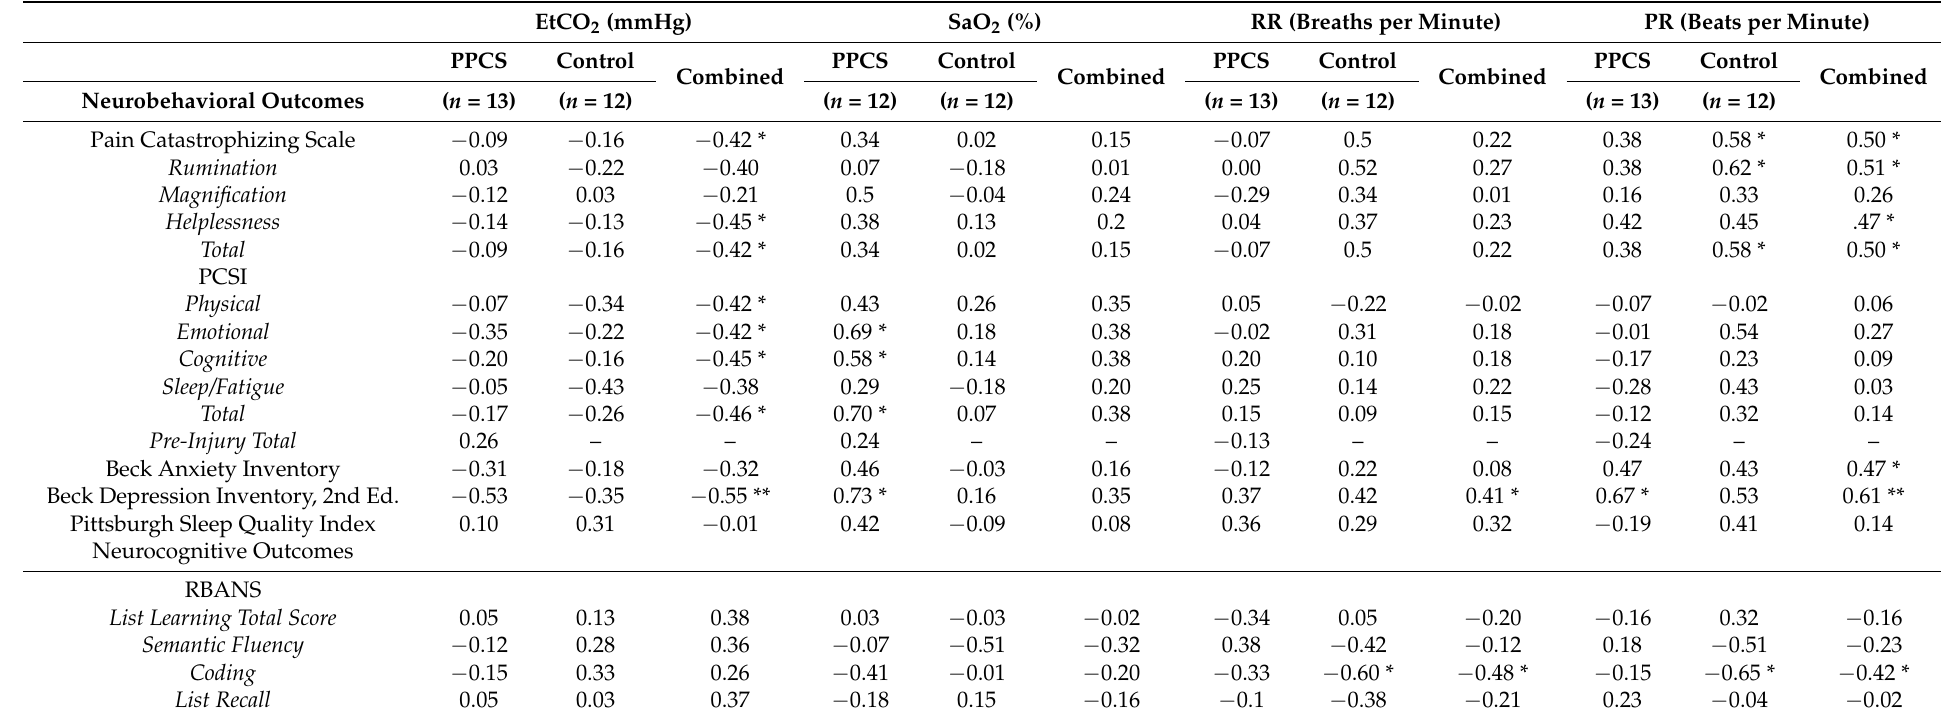
Table 3. Correlation coefficients of neurobehavioral outcomes and cardiorespiratory